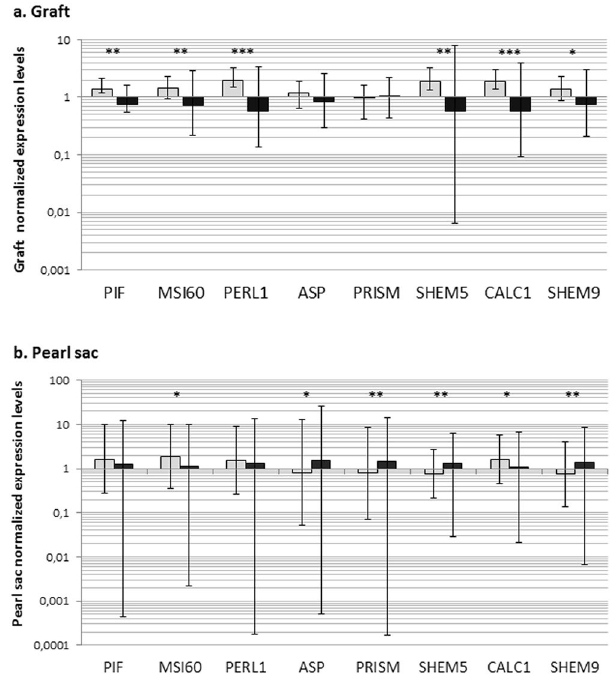
Figure 4. Relative expression of 8 biomineralisation genes in P. margaritifera in: ( a ) the mantle graft (N = 40) and ( b ) the pearl sac (N = 217 with 108 QL and 109 TL). Histograms in light grey represent data for the TL donor phenotype and histograms in dark grey represent data for the QL donor phenotype. Y axes are in logarithmic scale. Error bars correspond to standard deviations. Statistical differences between the two phenotypes are indicated by asterisks: * for 0.05 < p < 0.005, ** for 0.005 < p < 0.0005, *** for p <